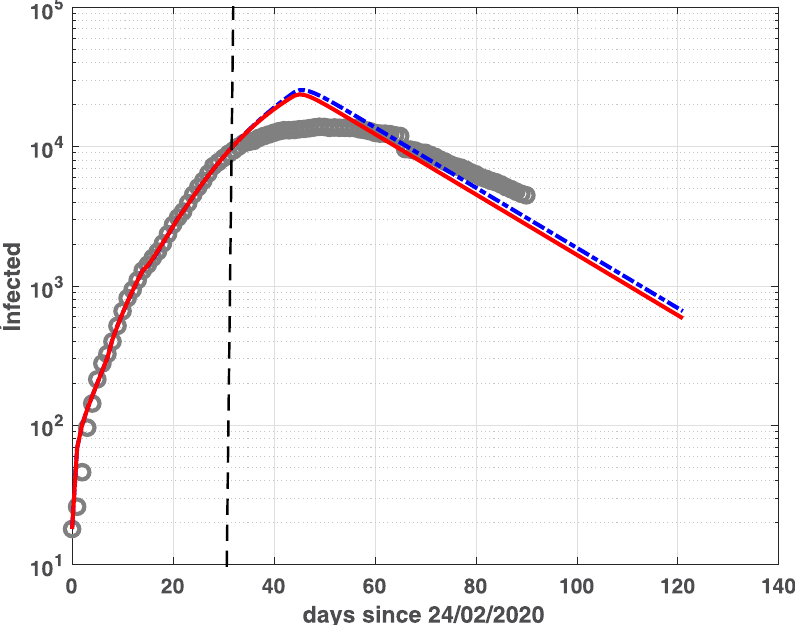
Fig 11. Prevision for infected in Emilia-Romagna. Infected population of fSEIRDe (continuous red line) and fSEIDRr (blue dash-dotted line) calibrated on the first 30 days observed infection data [24/02-27/03], delimited by the vertical black dashed line. Prediction is shown until 30 days after the last measured data (day 24/05). Grey circles represent the infected data in the period